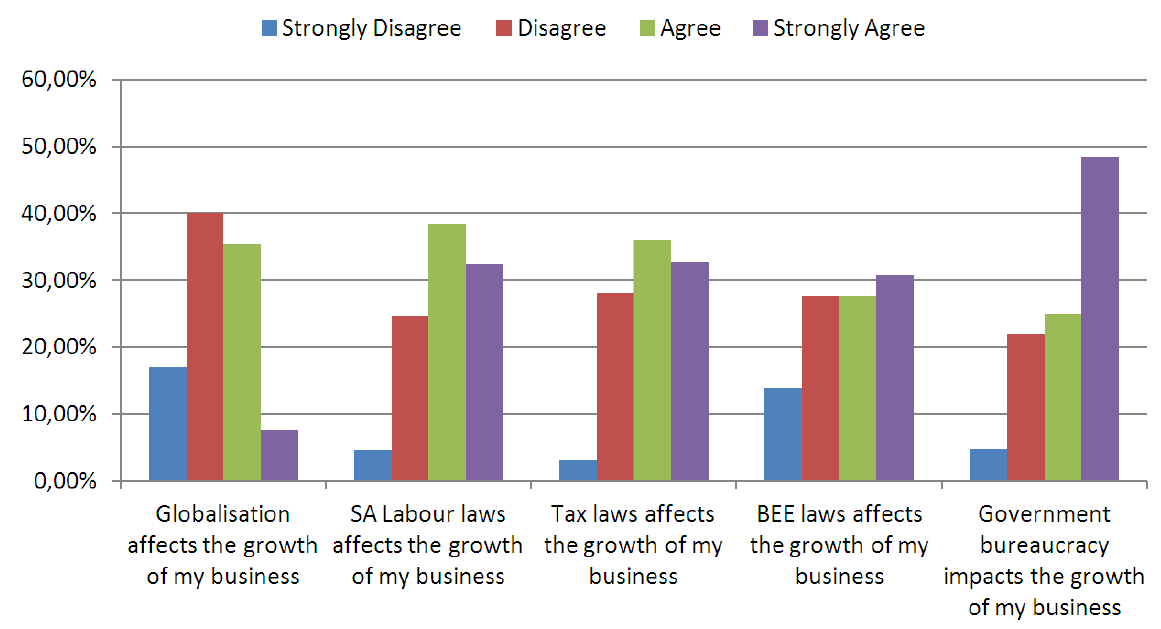
Fig. 2. Participants views regarding globalization, regulation and government bureaucracy impacting SMEs in KZN,